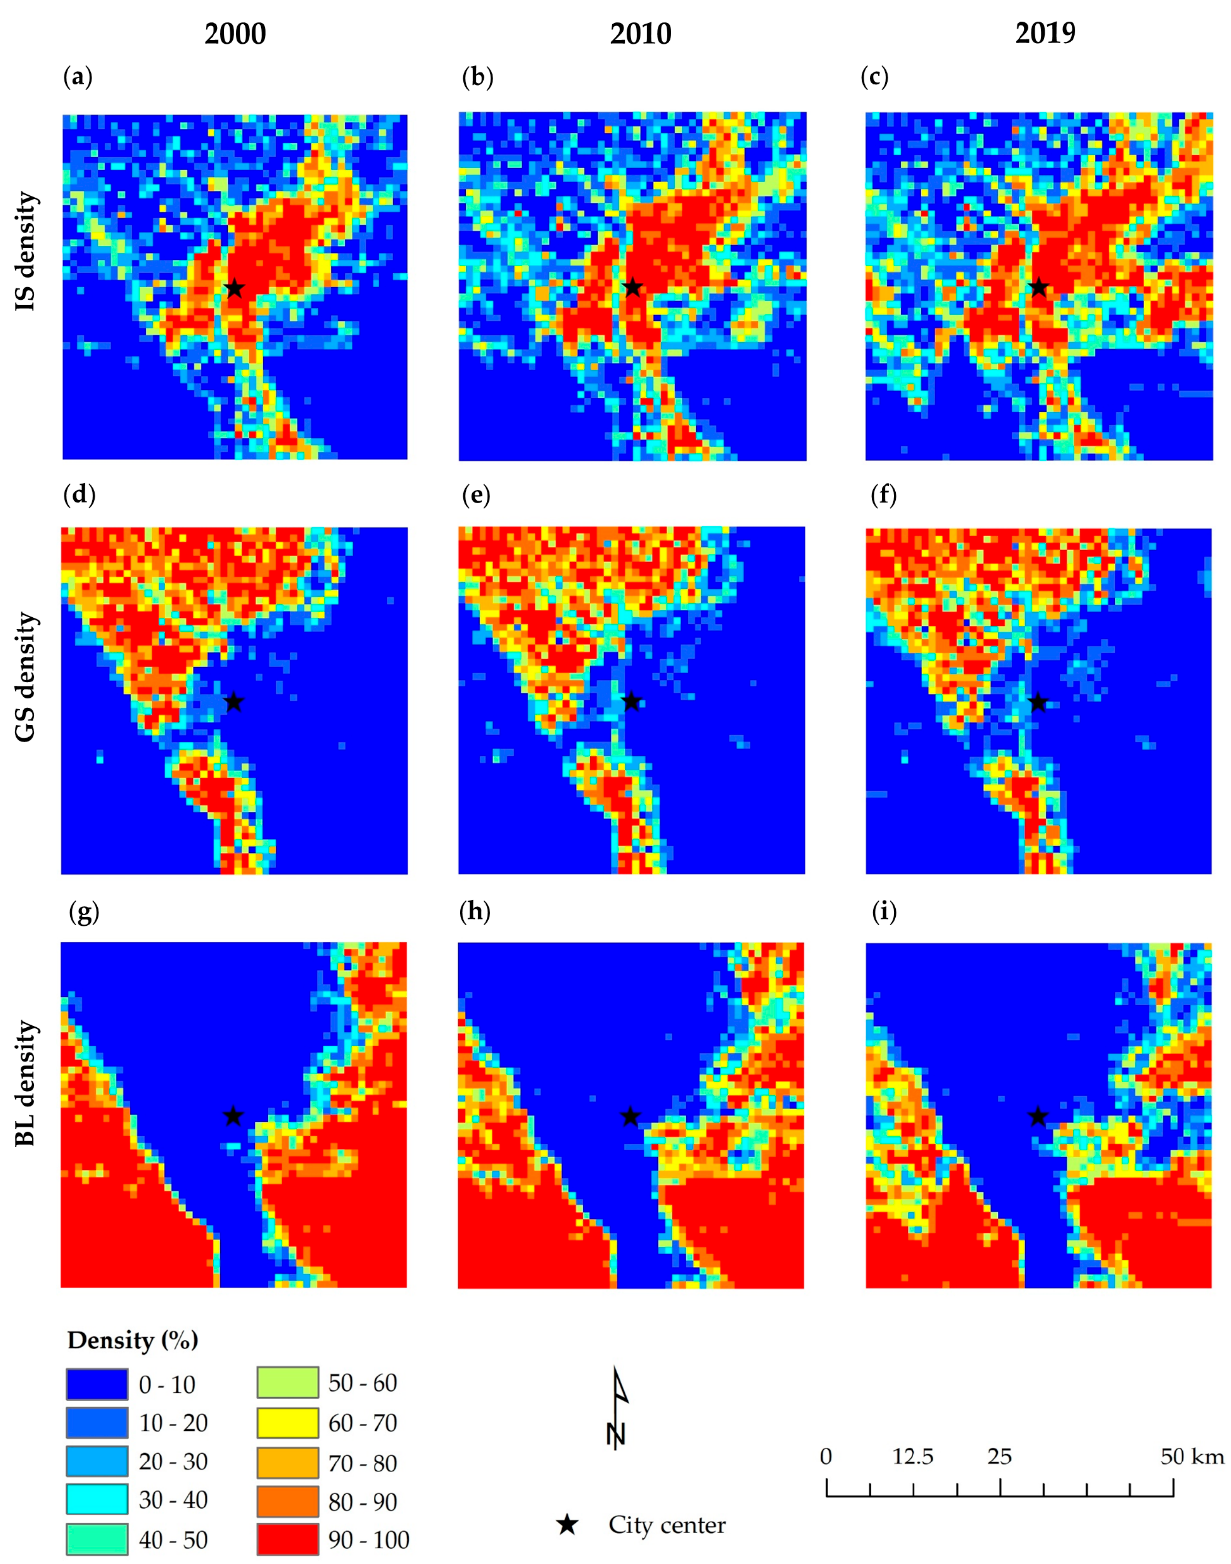
Figure 3. Distribution of impervious surface (IS), green space (GS), and bare land (BL) densities (1 × 1 km grid) of the study area: (a) IS density in 2000; (b) IS density in 2010; (c) IS density in 2019; (d) GS density in 2000; (e) GS density in 2010; (f) GS density in 2019; (g) BL density in 2000; (h) BL density in 2010; and (i) BL density in 2019.